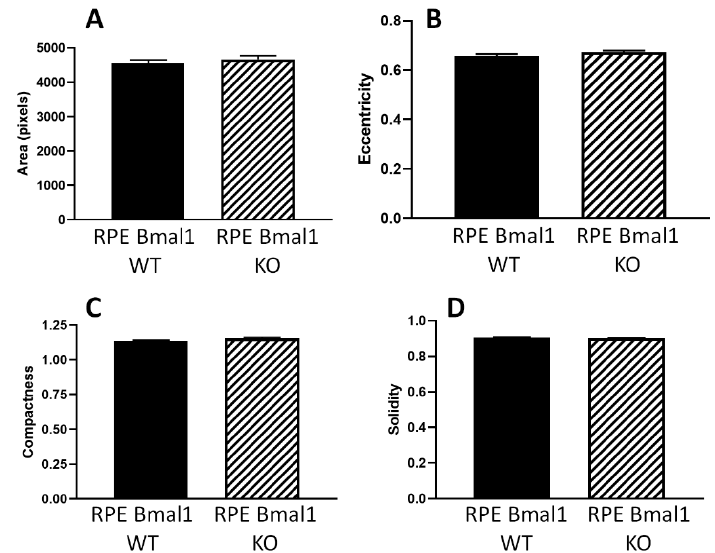
Figure 9. RPE morphology is not affected with loss of Bmal1 in the RPE. Because RPE cells have a unique cell morphology, we were interested to determine if cell shape parameters would change as a result of prolonged circadian disruption. Using cell profiler (v2.2.0), we were able to measure the area, eccentricity, compactness, and solidity of RPE cells. No differences were observed in any of the four shape parameters measured in old RPE Bmal1 KO mice compared to RPE Bmal1 WT mice ( A – D ; p > 0.05, unpaired t -test, n = 5 – 6/group). Data are expressed as mean ± SEM.